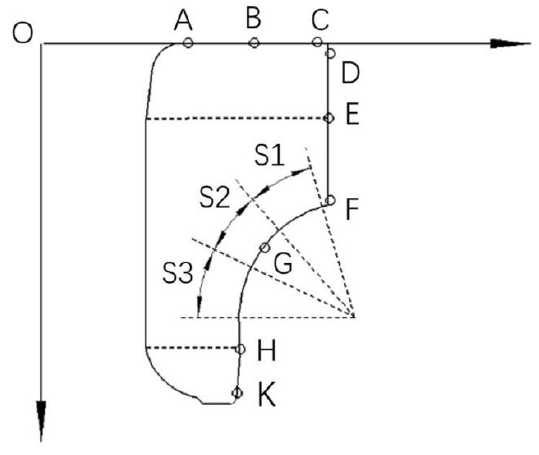
Figure 4. Measurement points along the generatrices of the inner ring.